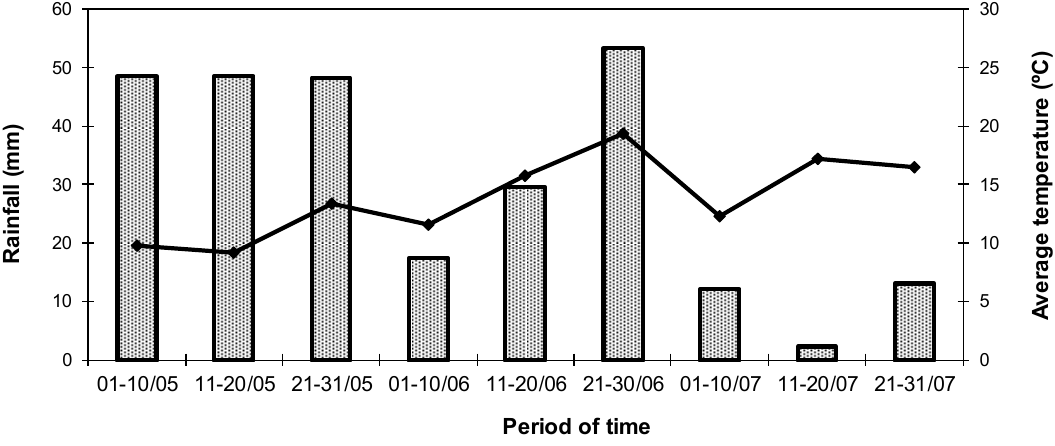
Figure 1. Gaussen ombrothermic diagram of the study site (Marcenat, France) from 1 May until 31 July in the period of 10-days including the experimental period when forage tested was grown (from 30 May to 1 July). Bars indicate rainfall. Average temperatures are line joined.